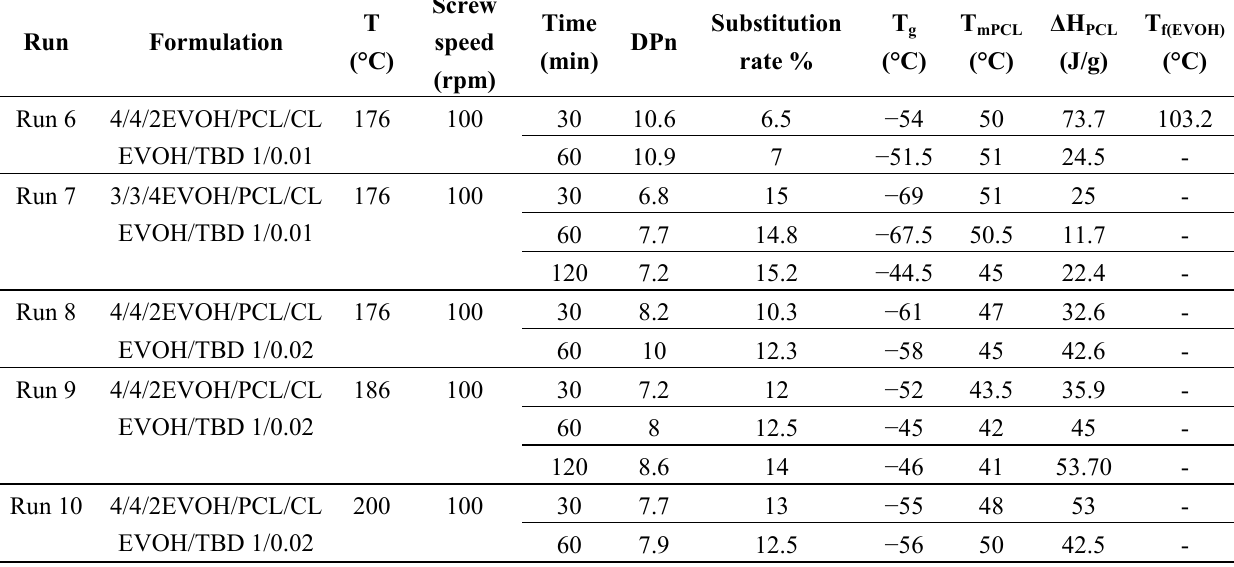
Table 4. Thermal transitions obtained by DSC and substitution rates calculated from 1 H study the influence of concentration of catalyst (runs 6 and 8), quantity of ε -caprolactone (runs 6 and 7) and temperature (runs 8, 9 and